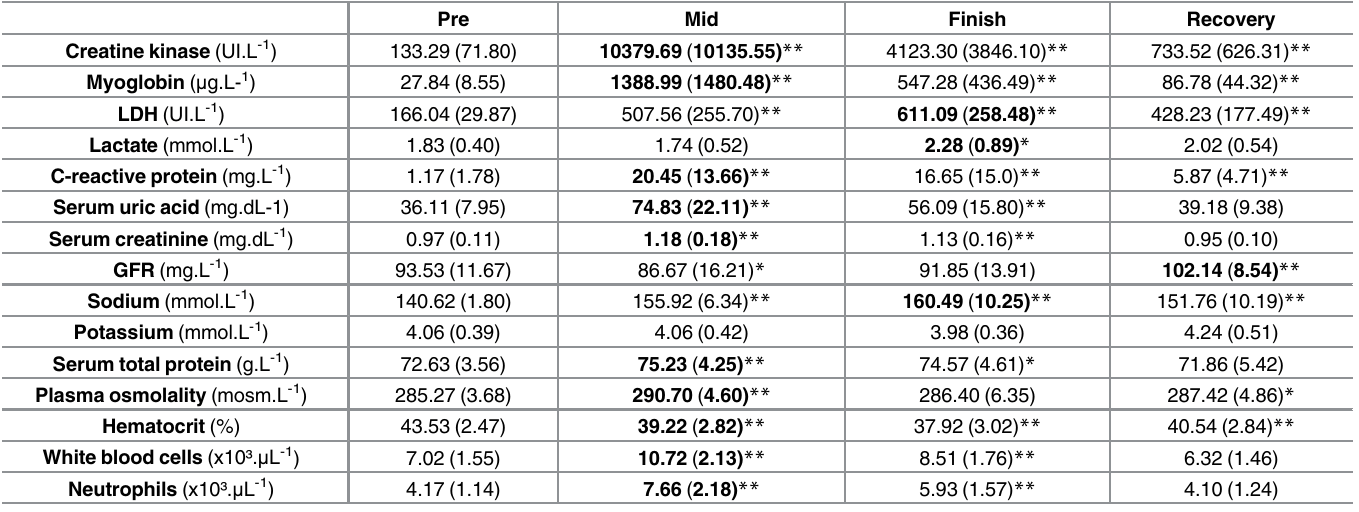
Table 4. Longitudinal variations in blood biomarkers throughout the ultra-marathon race.